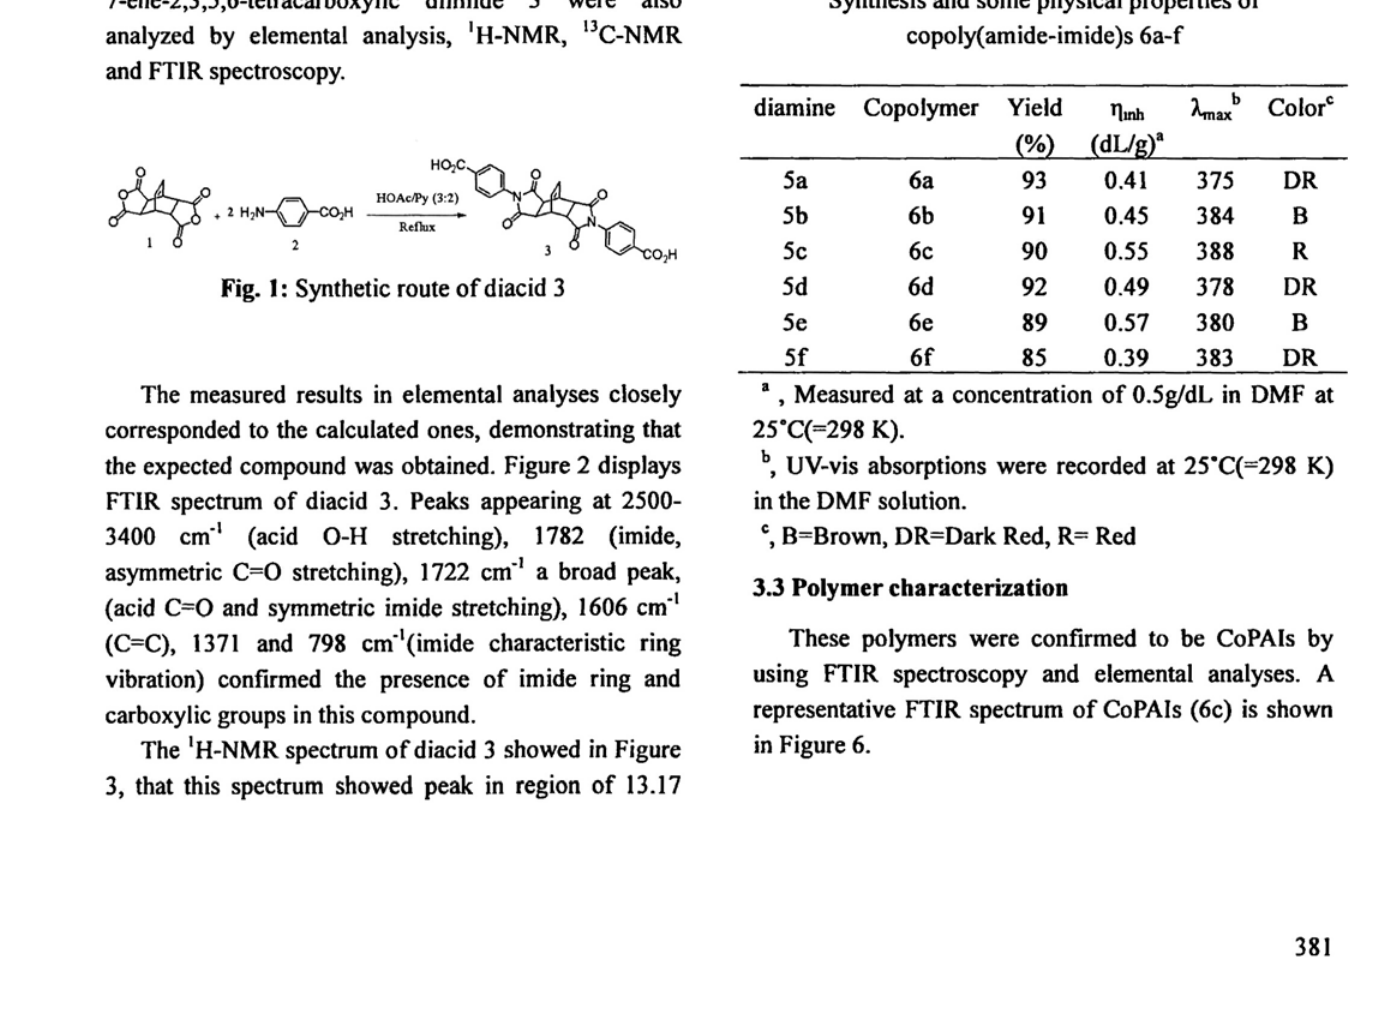
Fig. I: Synthetic route of diacid